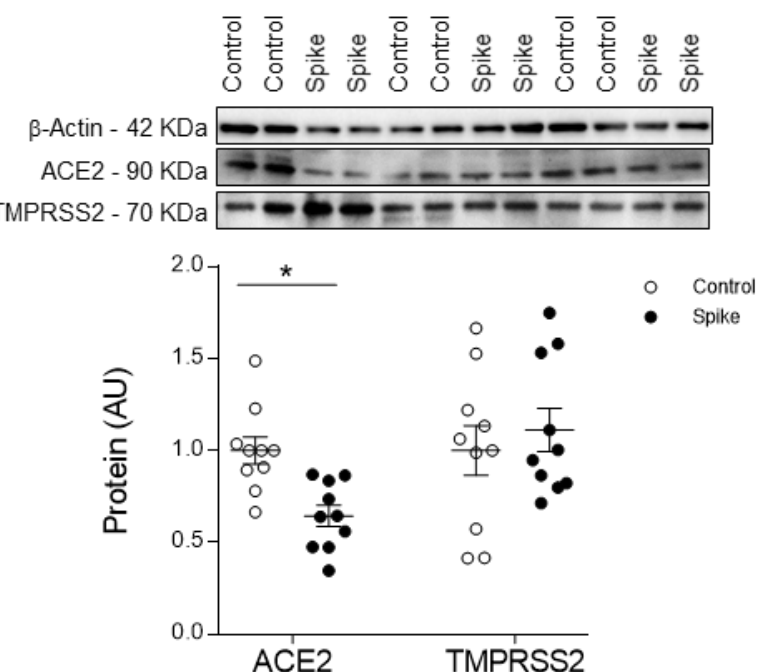
Figure 1. ACE2 and TMPRSS2 expression in HAECs. Quantification of ACE2 and TMPRSS2 in controls and Spike-treated cells. Whole original blots are displayed for ACE2, TMPRSS, and β -actin. The graphs represent the mean ± SEM of each group in arbitrary units (AU) normalized to the signal of stain-free protein gels or β -actin. n = 10 wells per condition from 4 independent HAECs donors. * p < 0.05 vs. control.